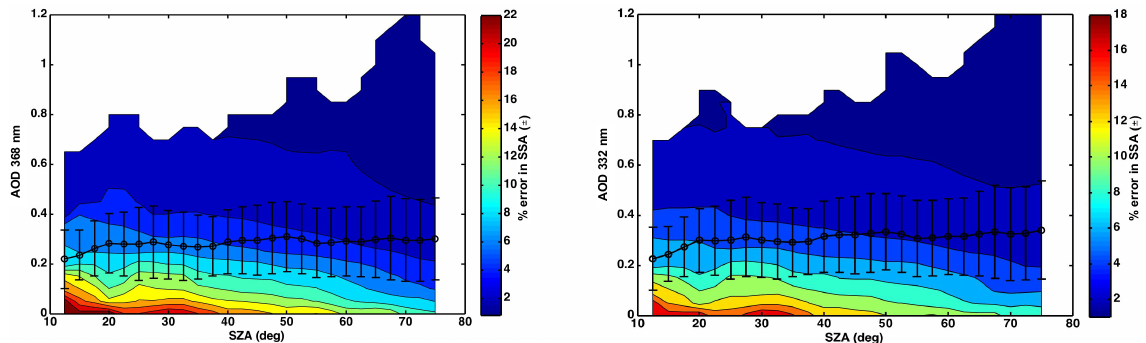
Figure 7. Uncertainty estimate (color) for the SSA retrieval from UVMFR as a function of AOD and SZA at 368nm (left panel) and 332nm (right panel). This is based on DGR and AOD uncertainties. Superimposed, mean AODs for 2.5 ◦ bins of solar zenith angle are